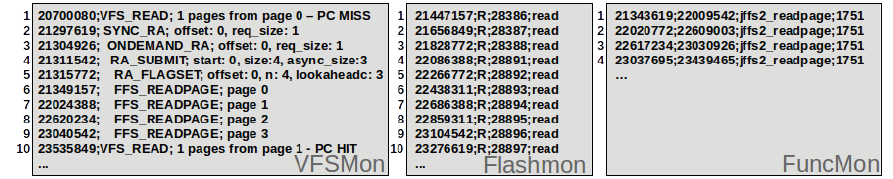
Figure 2: Sequential file read - output samples for VFSMon (left), Flashmon (center) and FuncMon (right). page was